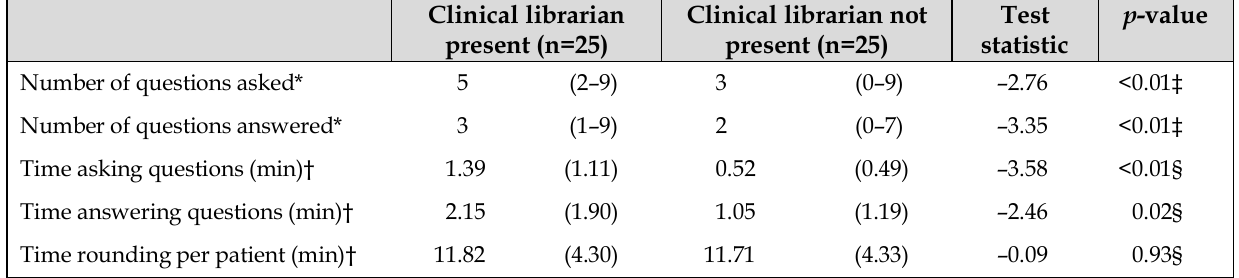
Table 1 Differences in number of questions and time spent asking and answering clinical questions between clinical librarian present on rounds and clinical librarian not present on